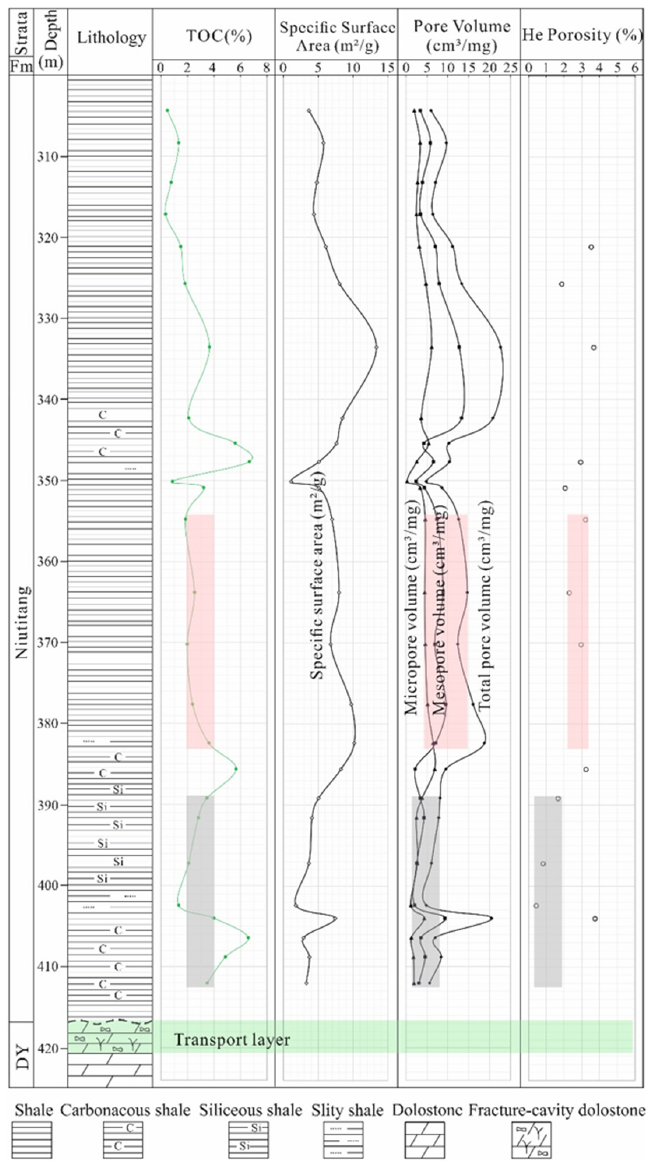
Figure 12. Depth profiles of the total organic carbon (TOC) content, specific surface area, pore volume, and He porosity for the Niutitang shale at the Kaiyang section (data from [31]). The floor interval with high permeability (as the transport layer) is shown in green. The shale interval (grey zone) closing to unconformity and transport layer has a relatively lower pore volume and porosity than the above shale interval (pink zone) with similar TOC. DY = Dengying, Fm = Formation.